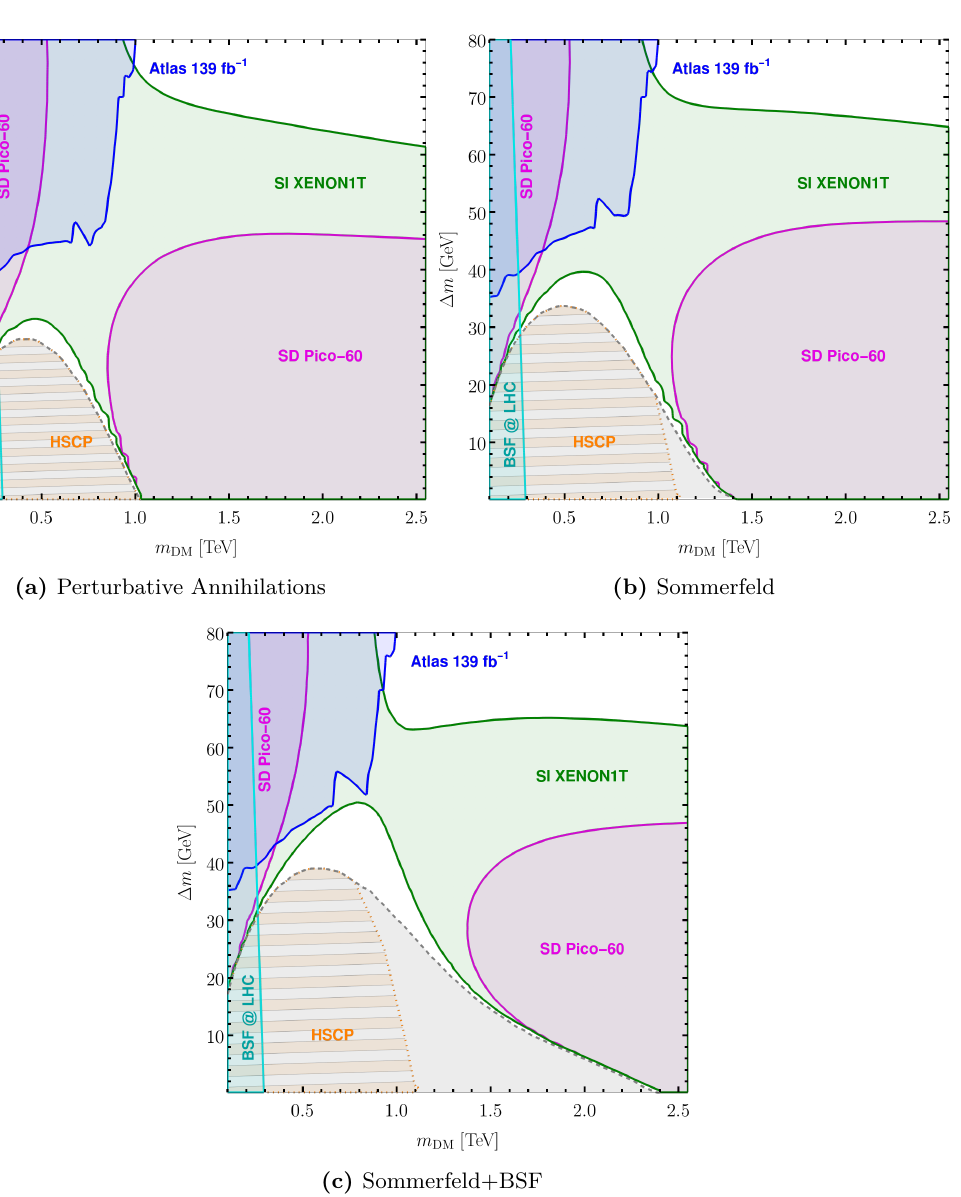
Figure 11. Exclusion limits from various experiments in the co-annihilating area. As before, the limits from spin-independent DD (spin-dependent DD, colliders, unitarity, stoponium searches) are colored in green (magenta, blue, black, cyan). In addition, we provide an estimate for the potential reach of LLP searches constraining the area of the parameter space where the correct relic density can be reproduced only via non-thermal mechanisms, such as conversion-driven freeze-out or freeze- in. Those regions are marked in